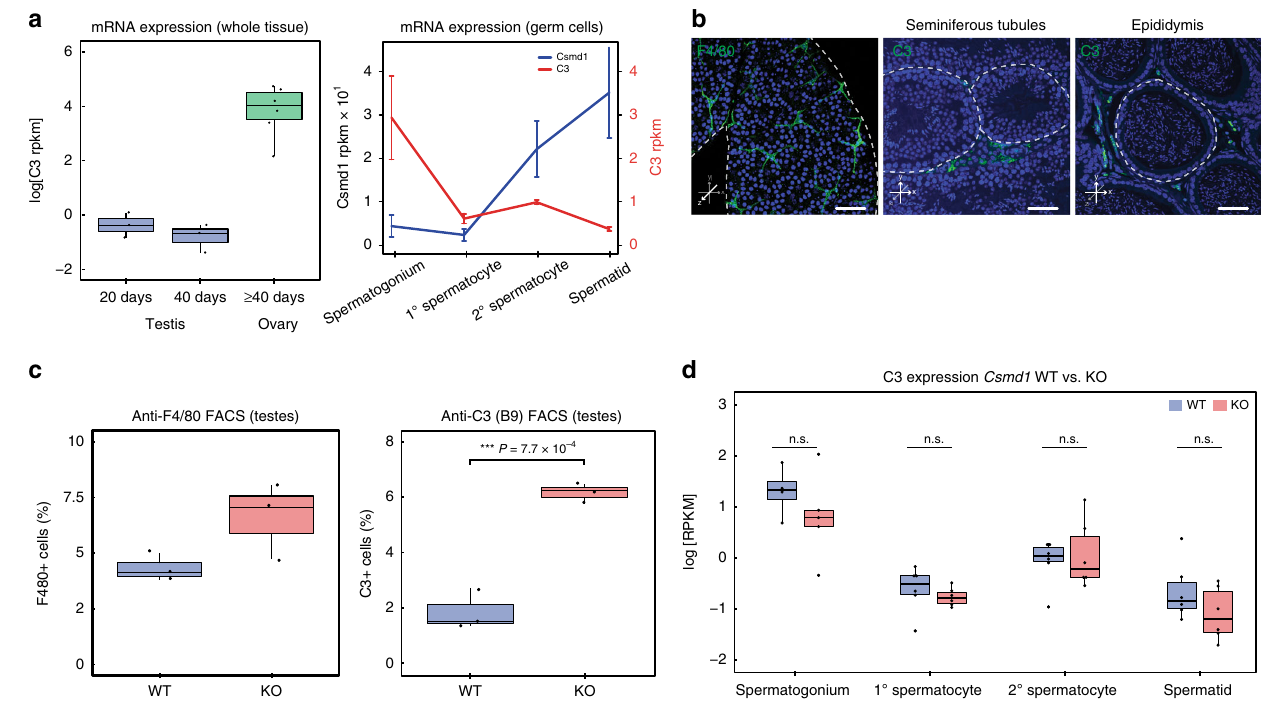
Fig. 4 Normal and aberrant complement C3 localization in Csmd1 wildtype versus knockout testes. a C3 mRNA expression in sexually immature whole testes, sexually mature whole testes, and whole ovary. RNA-seq of FACS-puri fi ed germ cell populations shows C3 expression decreases throughout spermatogenesis. Csmd1 expression data from Fig. 2 are rescaled and superimposed for ease of comparison. Line chart error bars re fl ect standard error of the mean. b Complement and macrophages are con fi ned to the interstitial compartment in normal tubules. F4/80 immuno fl uorescence of whole mount tubule preparations shows abundance of macrophages along the interstitium (left). C3 immuno fl uorescence of tubule cross-sections shows expression in the interstitium, but not within the lumenal compartment (middle). Cross-section of downstream epididymis shows continued exclusion of C3 from the lumenal compartment (right). Individual tubules are circumscribed by dashed lines. Scale bars = 50 μ m. c Boxplots depicting F4/80 abundance and C3 protein deposition in FACS-sorted Csmd1 wildtype vs. knockout testes. Both F4/80 and C3 are increased in Csmd1 knockout testes, though only signi fi cant for C3 (ANOVA p -value = 7.7 × 10 − 4 ). d RNA-seq of Csmd1 wildtype vs. knockout germ cell populations shows no signi fi cant difference in C3 mRNA expression (two-tailed t- test; p -value > 0.05). For all boxplots, center line = median; hinges = upper and lower quartiles; whiskers = 1.5 × interquartile range. Source data are provided as a Source Data fi